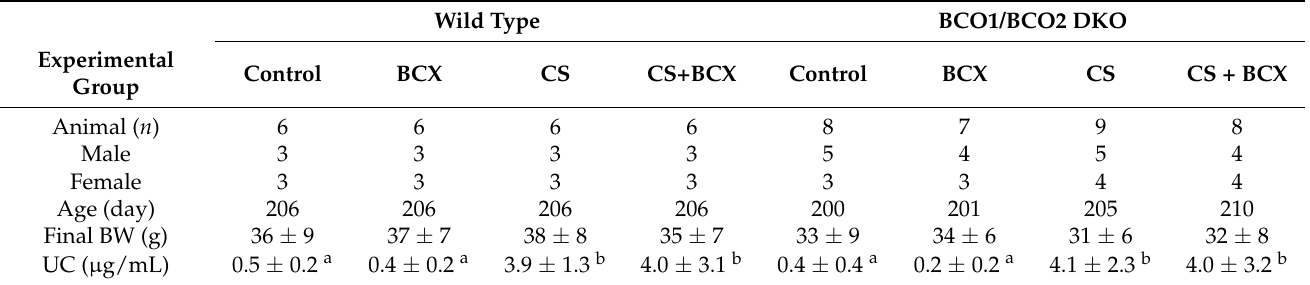
Table 1. Body weight (BW) and urinary cotinine (UC) of cigarette smoke (CS)-exposed wild type and BCO1/BCO2 double knockout (DKO) mice with or without β -cryptoxanthin (BCX) treatment. Wild Type BCO1/BCO2